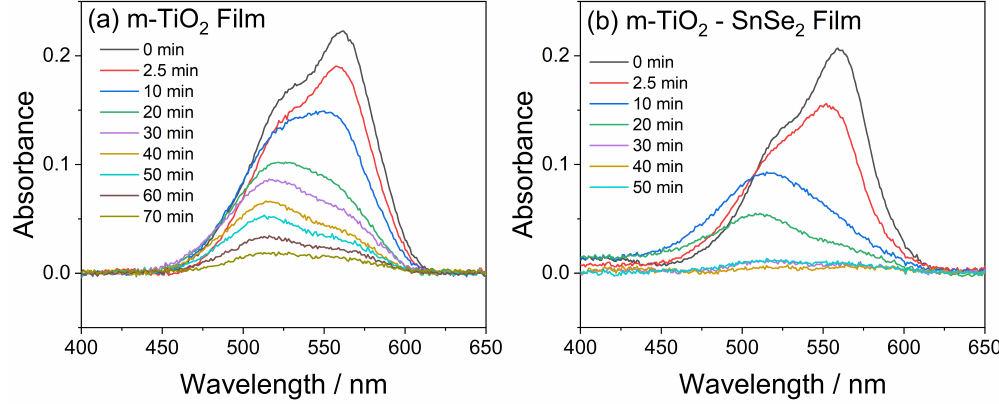
Figure 9. UV-Vis spectra of Rhodamine B deposited on m-TiO 2 ( a ) and m-TiO 2 -SnSe 2 ( b ) films as a function of UV exposure